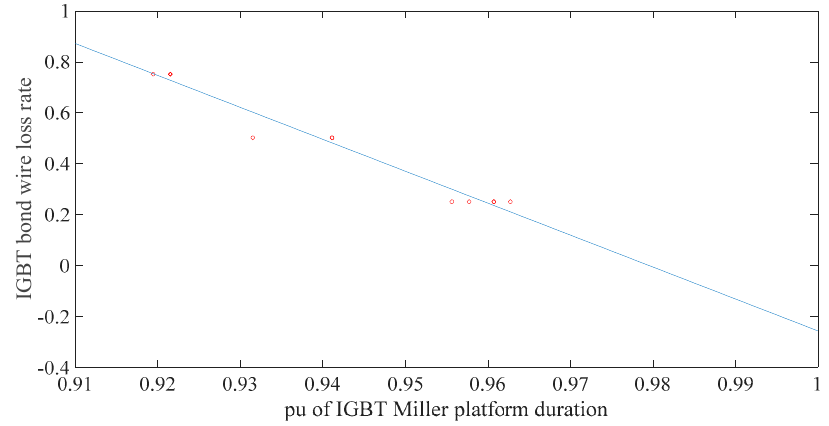
Figure 19. Fitted function between the univariate V m * and R loss.